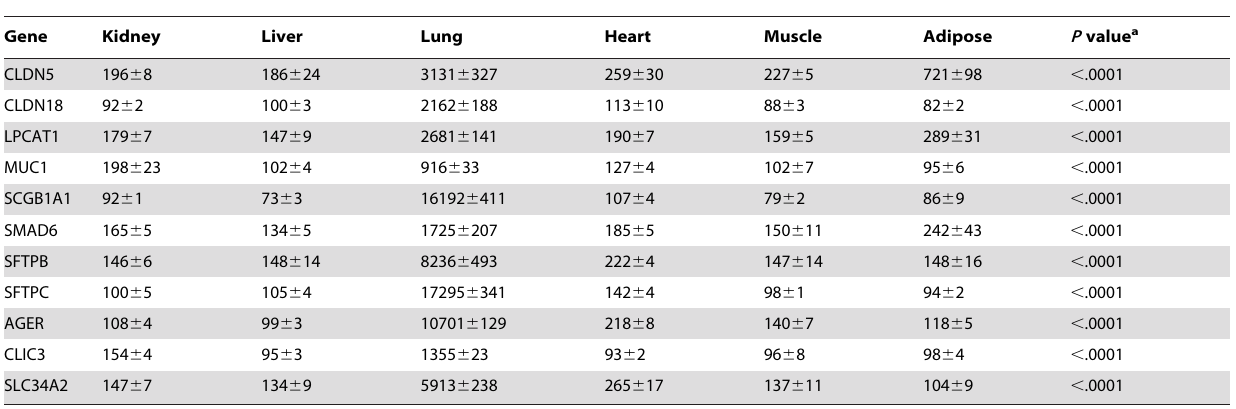
Table 7. Mouse lung-specific gene expression values.